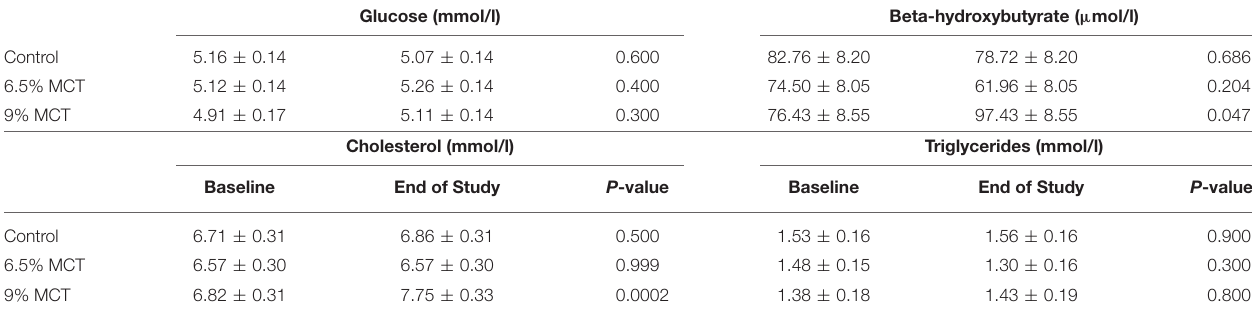
TABLE 3 | Effects of the diets on fasting blood glucose, BHB, cholesterol, and triglycerides in